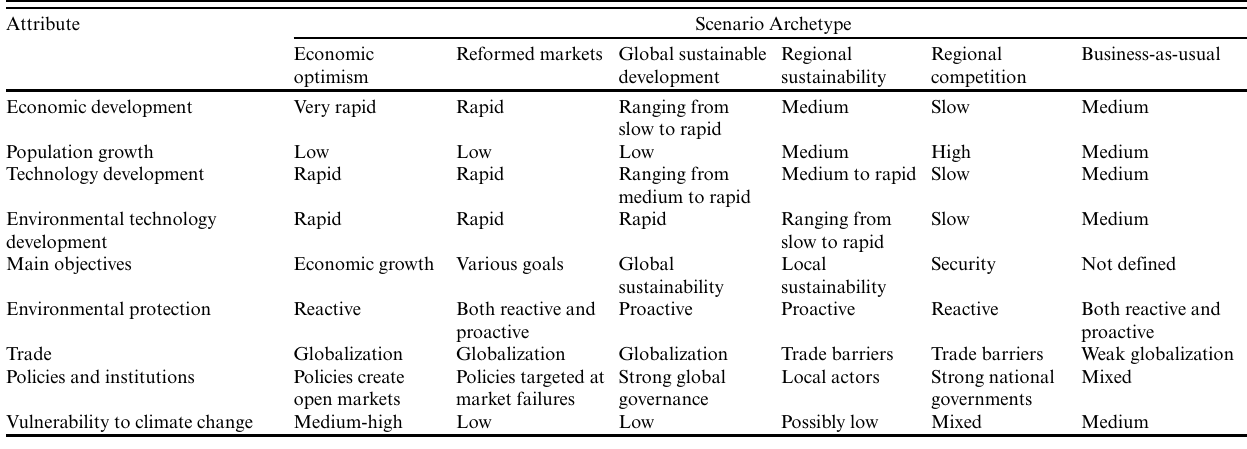
Table 1 . Overview of the original set of global archetypes and their underlying assumptions that were used as a starting point to classify scenarios within the Intergovernmental Science-Policy Platform for Biodiversity and Ecosystem Services (IPBES) regional assessments. The first column contains attributes typically used to describe scenario archetypes. Economic optimism scenarios focus on competition, efficient market, and economic growth; reformed market scenarios are similar to economic optimism but corrected for market failures; global sustainable development scenarios focus on environmental protection and reduction of inequality through global cooperation, lifestyle change using efficient technologies; regional competition scenarios feature regional self-reliance, national sovereignty and regional identity but also involve tensions with other regions; regional sustainability scenarios highlight globalization and international markets that are seen to erode traditional values and social norms; and finally business-as-usual scenarios that assume continuation of historical trends (Van Vuuren et al 2012, IPBES 2016). These were rationalized in the IPBES regional assessment (Biggs et al.